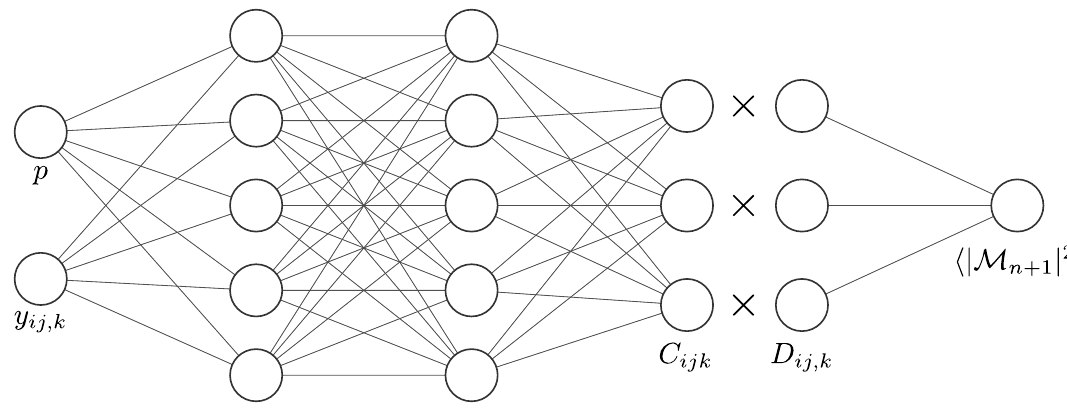
Figure 1 . Schematic diagram of our neural network architecture. We have a densely-connected neural network with inputs phase-space points, p , and recoil factors, y ij,k , propagated through hidden layers to the output layer which outputs C ijk . These coefficients are combined with their corresponding spin-averaged dipoles as in (2.2) to produce an approximation of the matrix element. Diagram of neural network generated with the aid of